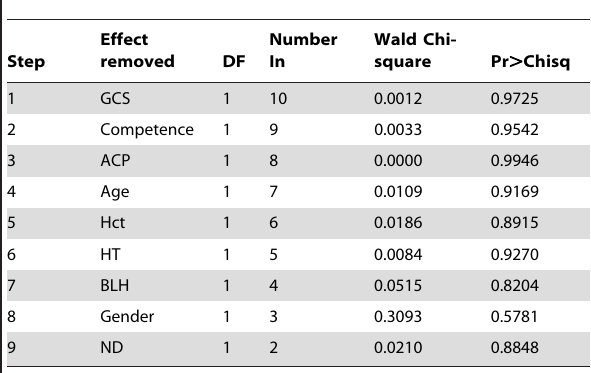
Combination of effects IFA and Na remained in model; LR=9.7944; p=0.0075 . Significant values are featured with bold font. Abbreviations: GCS: